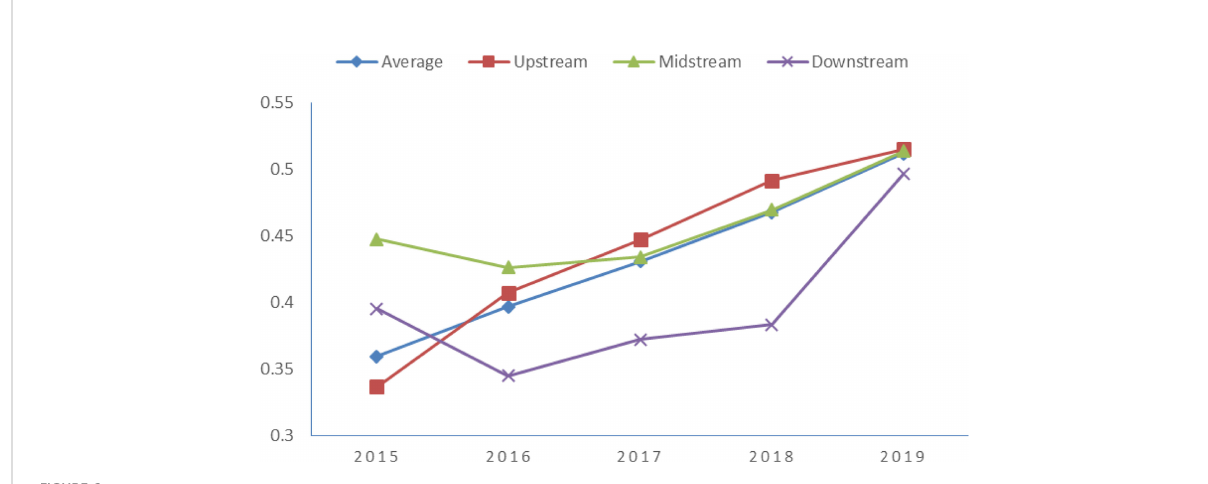
FIGURE 6 GTE of the average and each link of the industry chain under meta-frontier after adjustment,